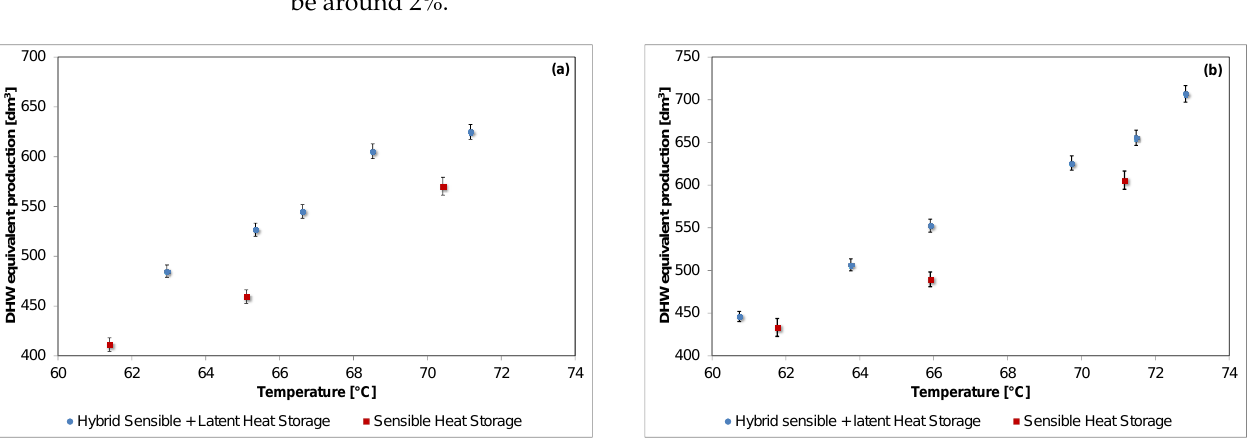
Figure 10. Comparison of equivalent DHW production for sensible and hybrid TES configurations obtained under Test A ( a ) and Test B ( b ) operating conditions.